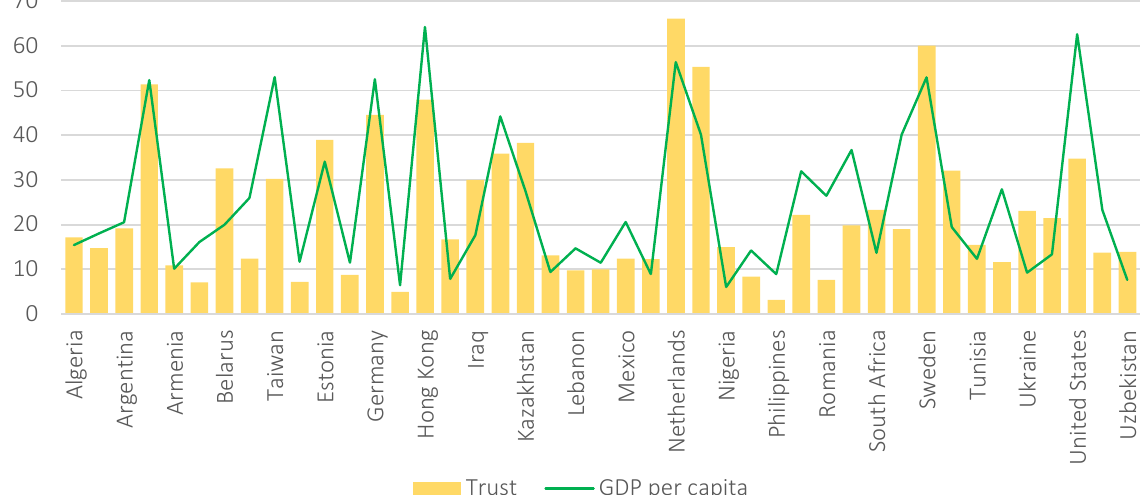
Figure 1. The correlations between trust and GDP per